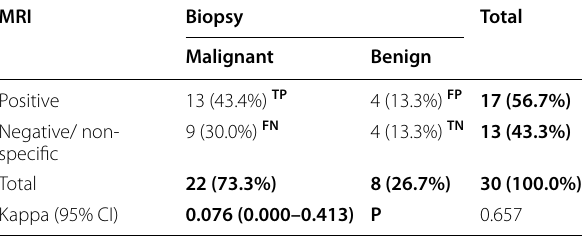
Percentages are from the total (30), TP : True positive, TN : True negative, FP : False positive, FN : False negative Bold values are referred to as significant value and better results than other filtering methods